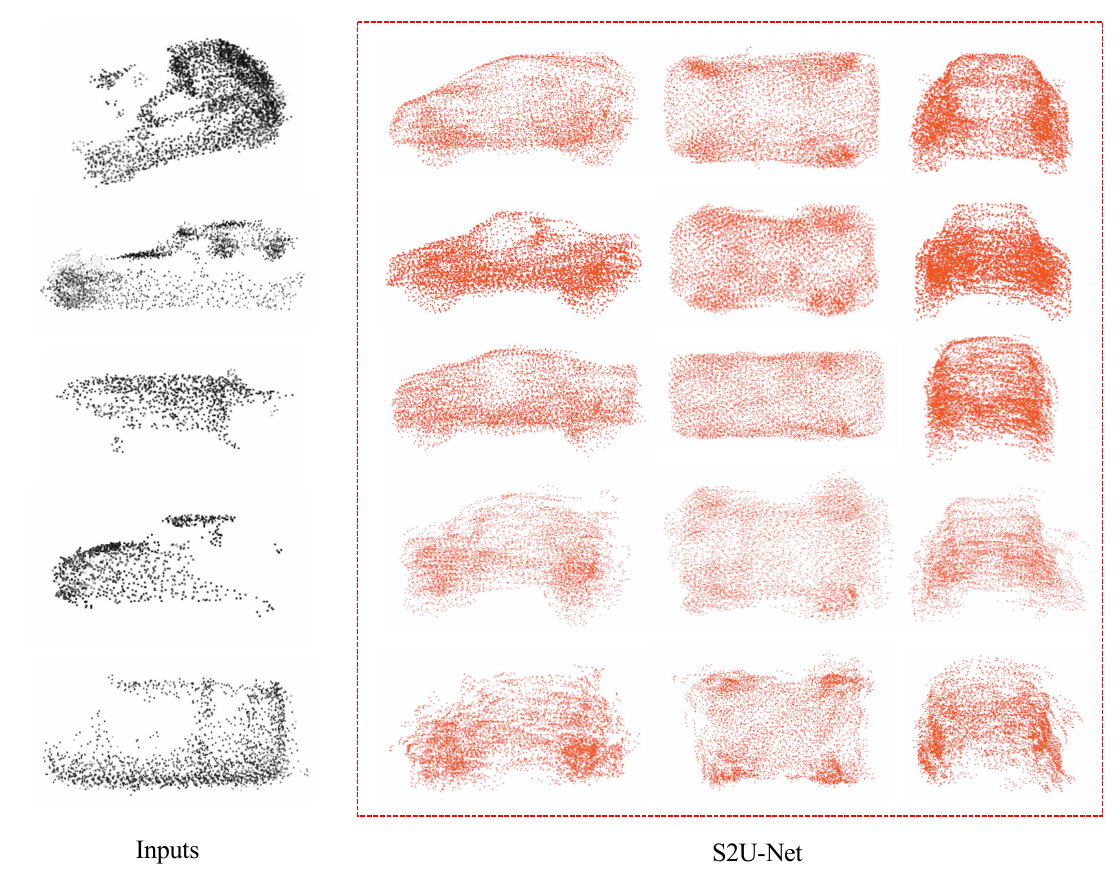
Figure 4. 3D point cloud completion for the shape of cars from the TUM City Campus dataset. The orders from left to right: input partial scans, completed results by